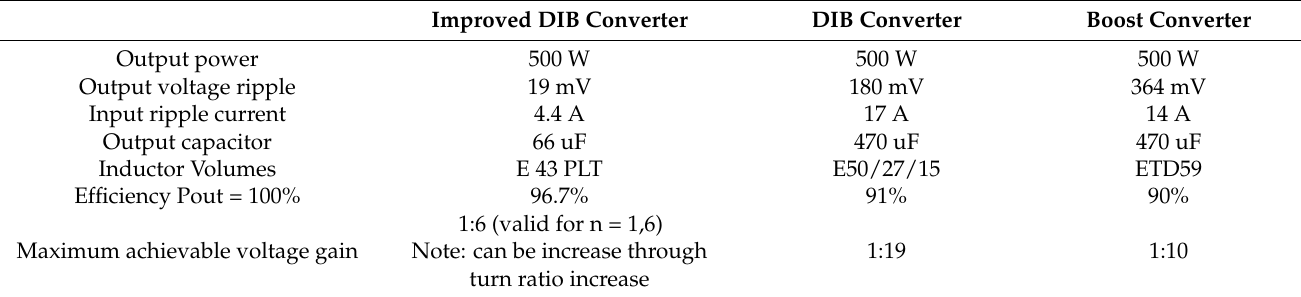
Table 1. Performance comparison of individual converter solutions of the maximum power point tracking (MPPT) block.